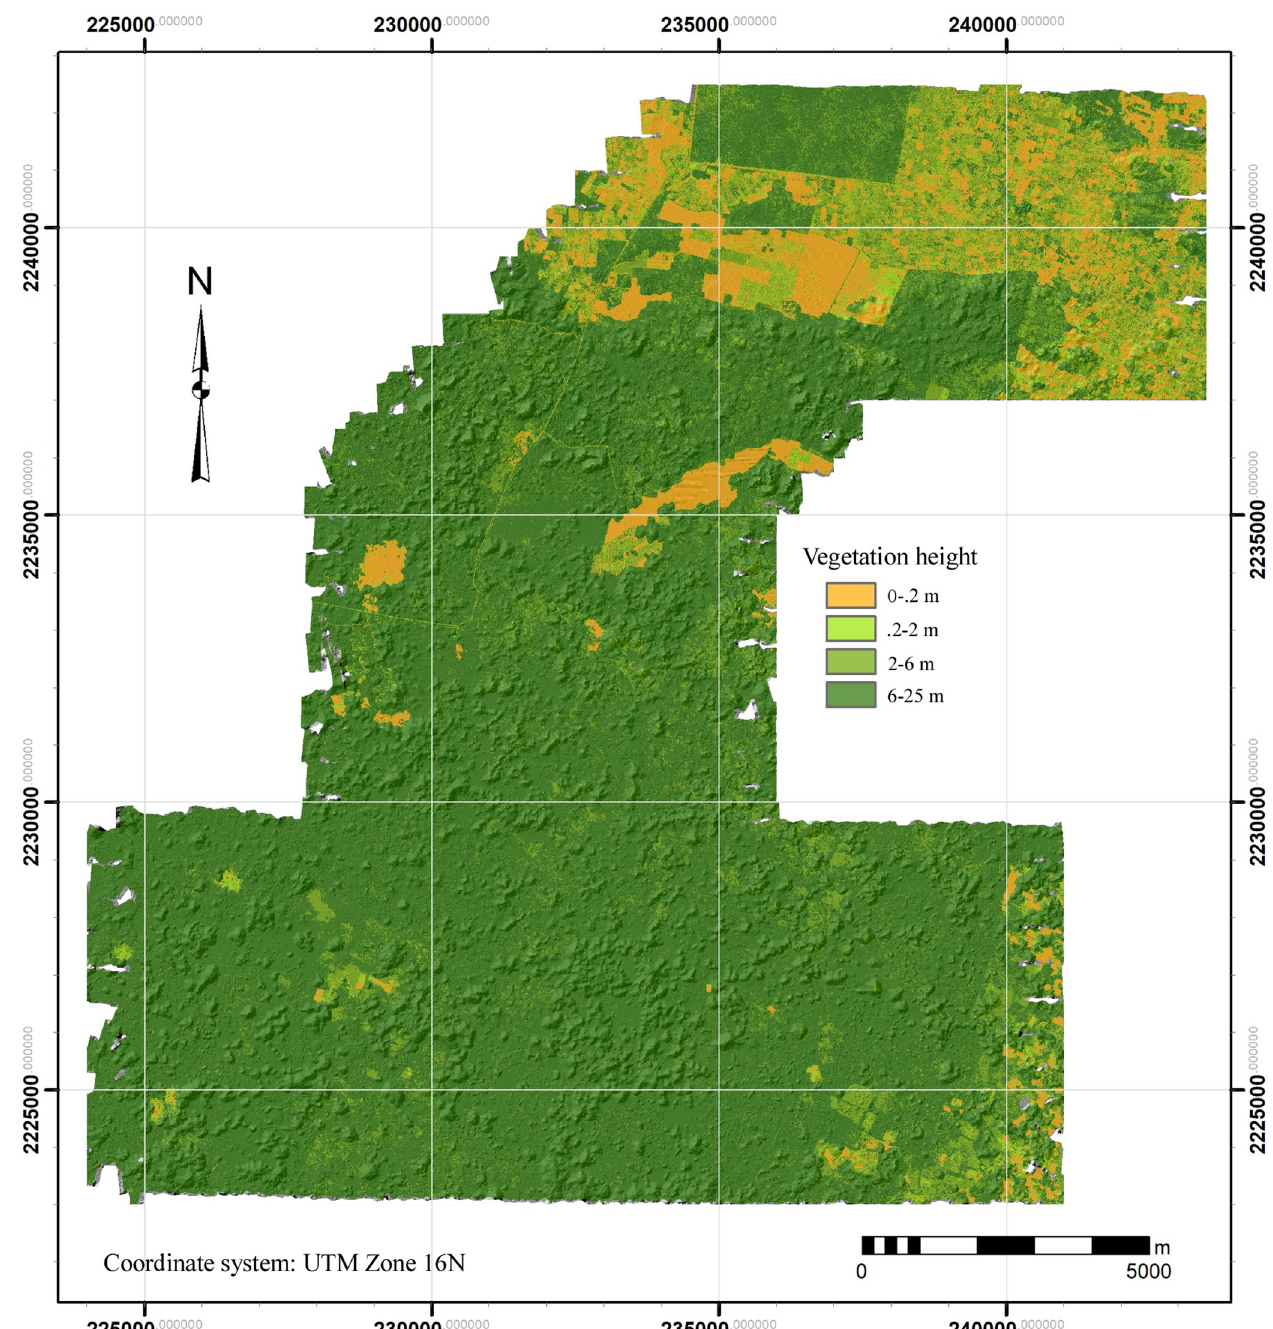
Fig 5. Vegetation classified by height in the NCALM sample (difference of the DSM and DTM raster layers). The greater part is medium tropical deciduous forest, in dark green.